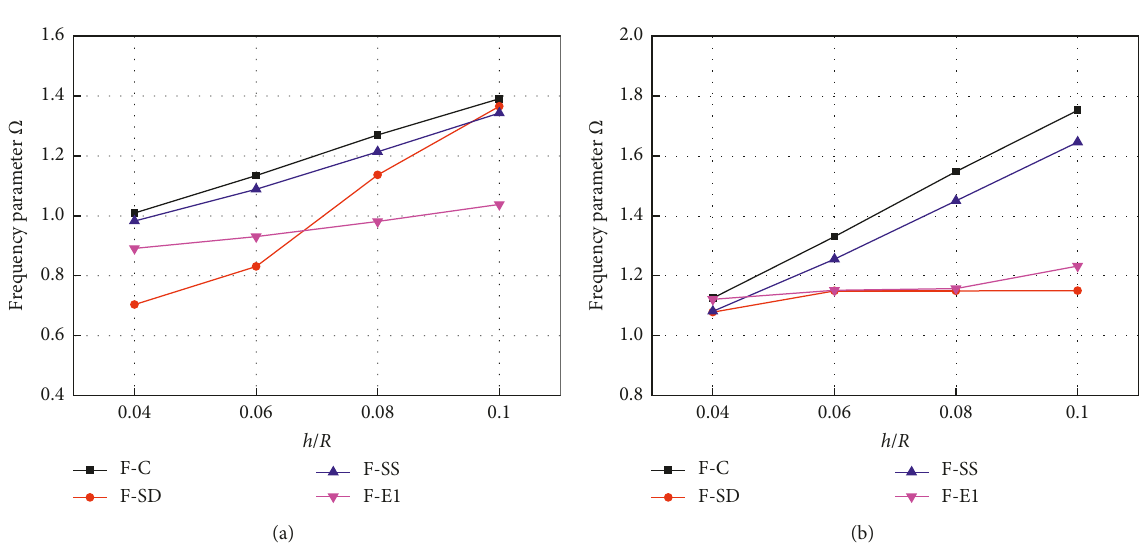
Figure 11: Frequency parameters Ω of FG spherical shell with respect to h / R ratio ( m � 3).